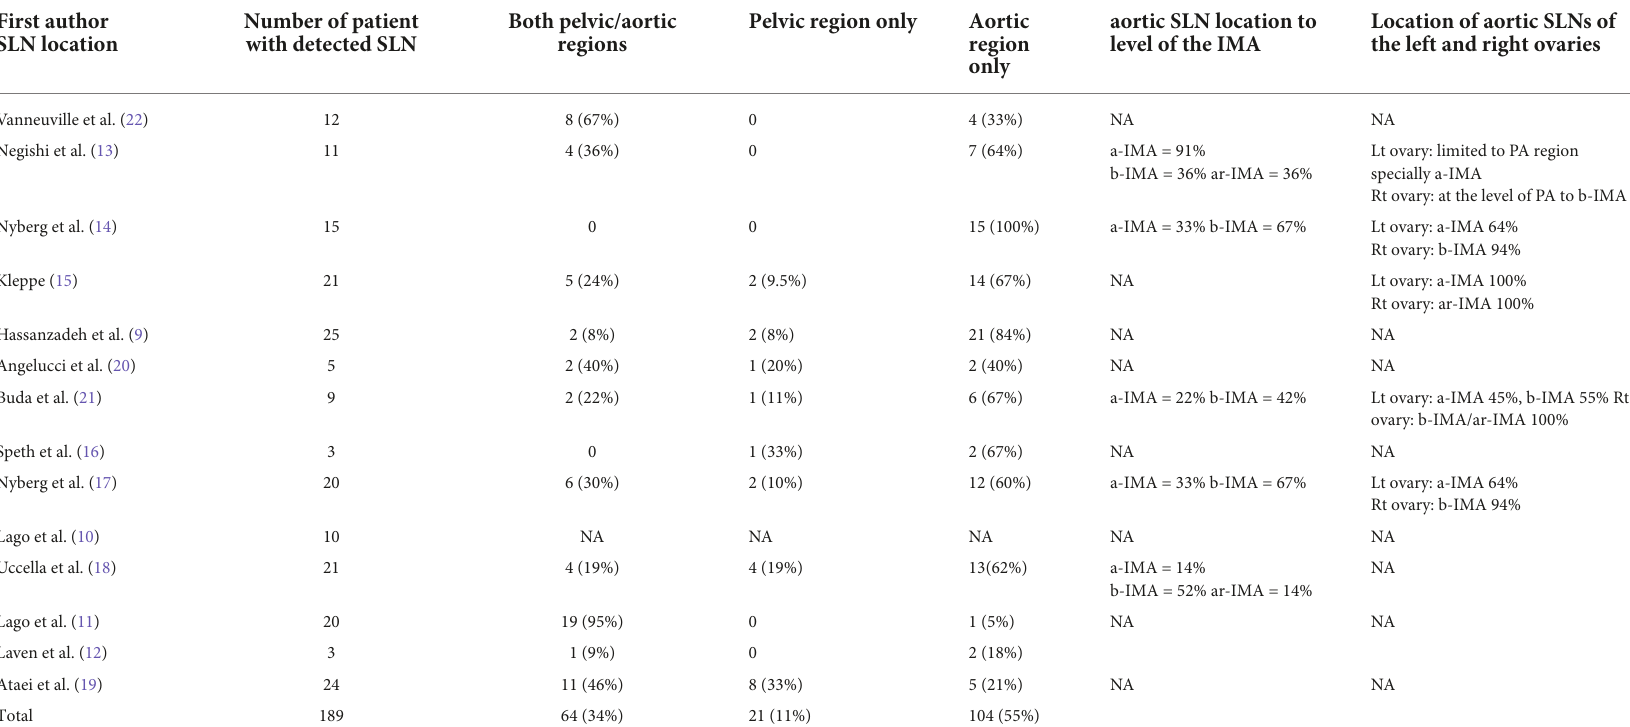
TABLE 3 Location of the ovarian Sentinal Lymph